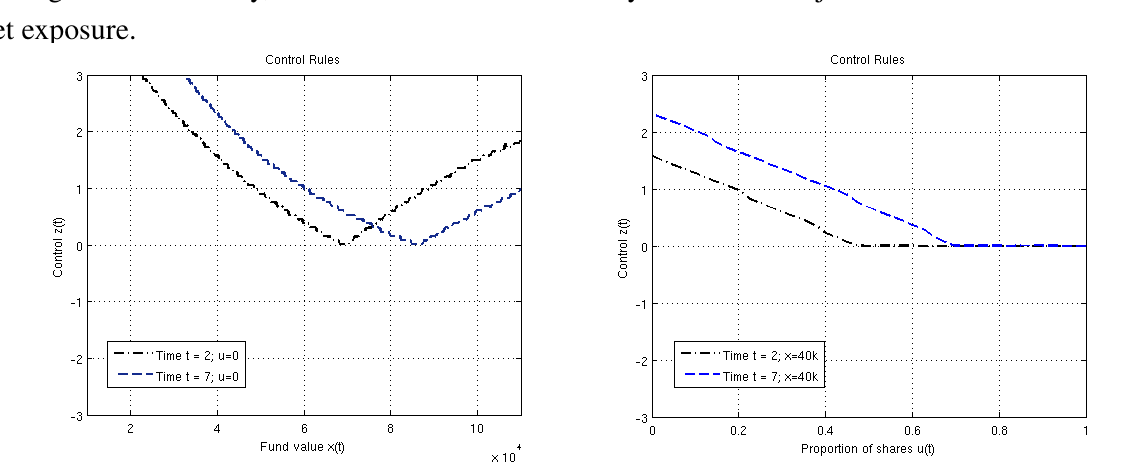
Figure 6. Control rules for t = 2 and t = 7 in x ( t ) and u ( t ) for b = 0 . 05 .